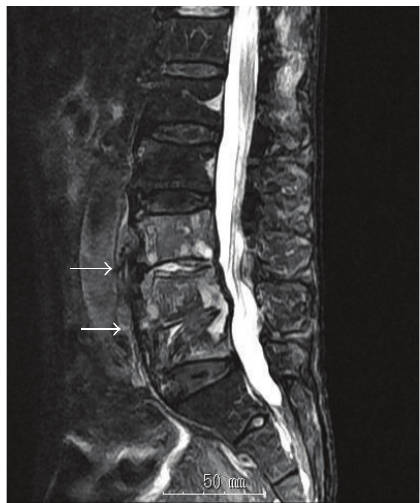
Figure 1: MRI showed the collapse of L5 and an increased signal intensity in the L3, 4, 5 vertebral body on T2 STIR images (arrow).